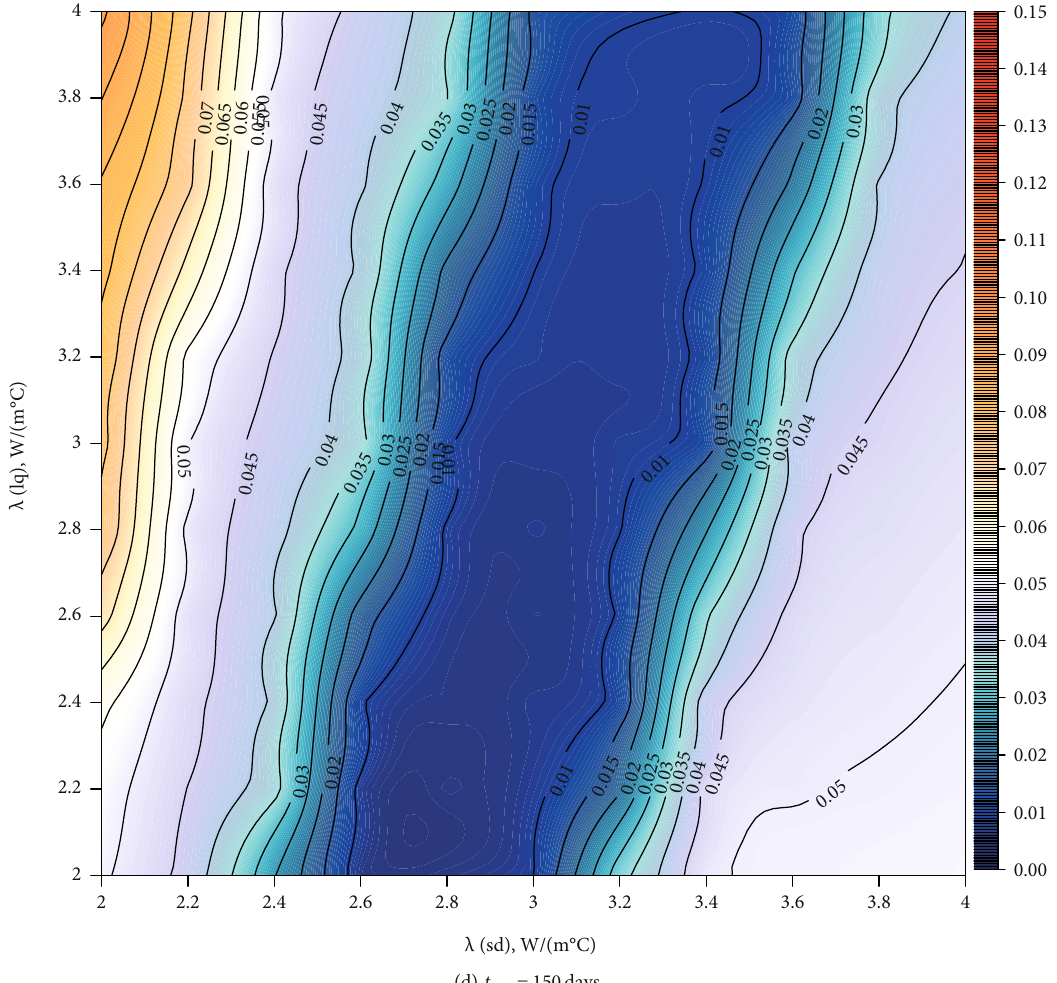
Figure 6: Isolines of the temperature discrepancy functional in the phase space of the minimization parameters ( λ freezing times for the sand layer (shaft no.